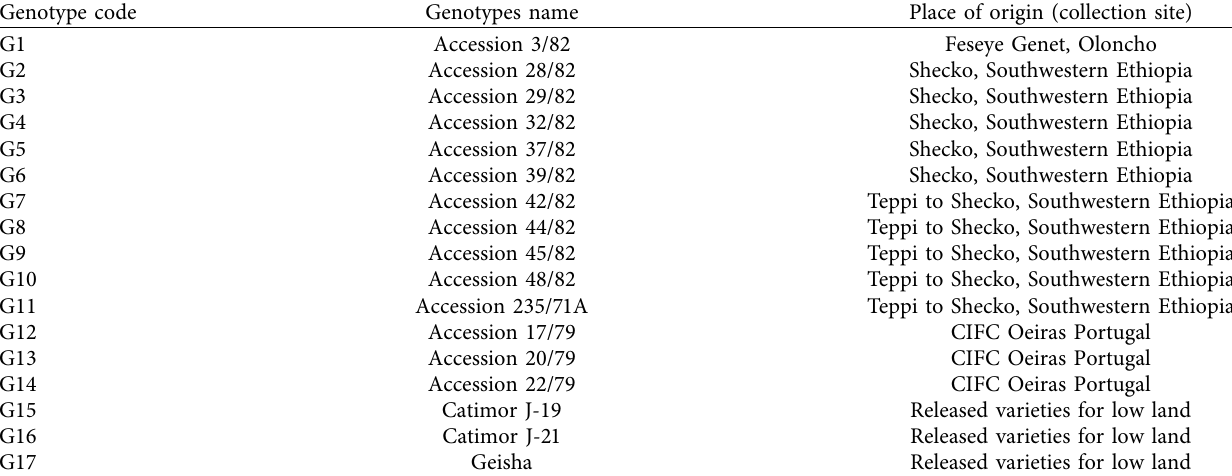
Table 2: Descriptive information of genetic materials